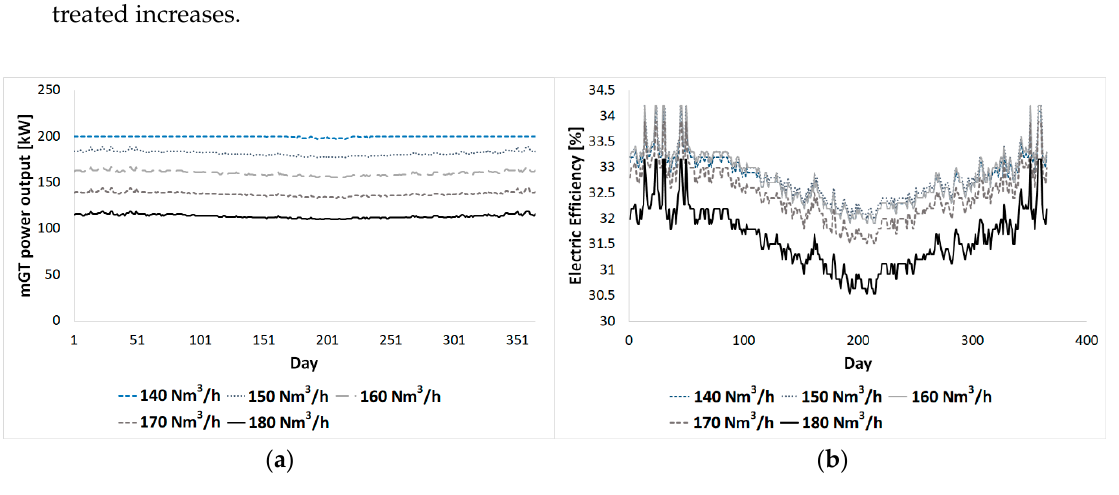
Figure 14. The natural gas consumption in the auxiliary boiler for various sizes of upgrading system.